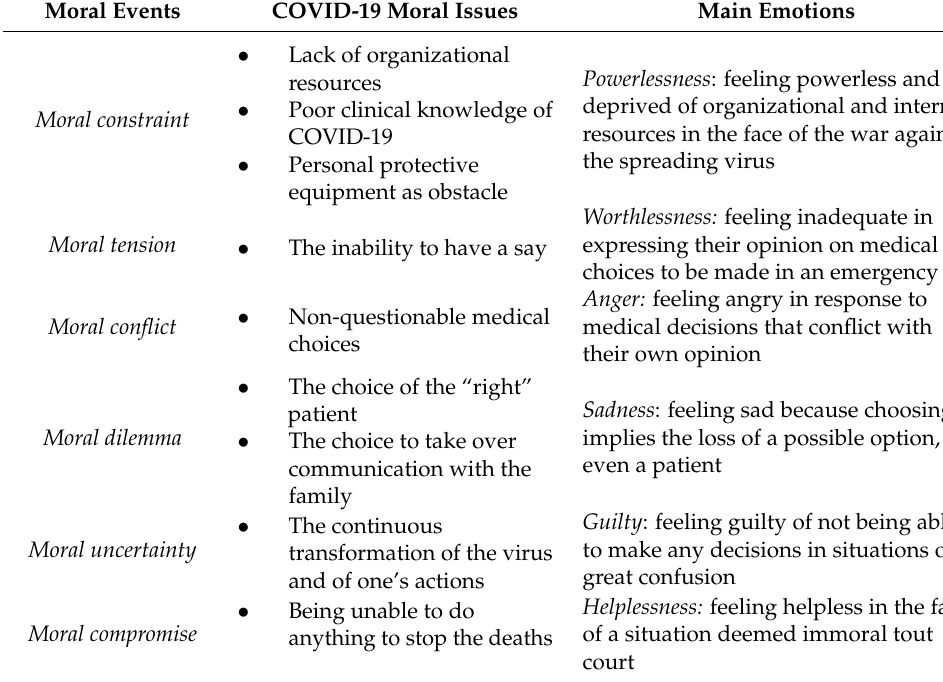
Table 2. Moral events, COVID-19 moral issues, main